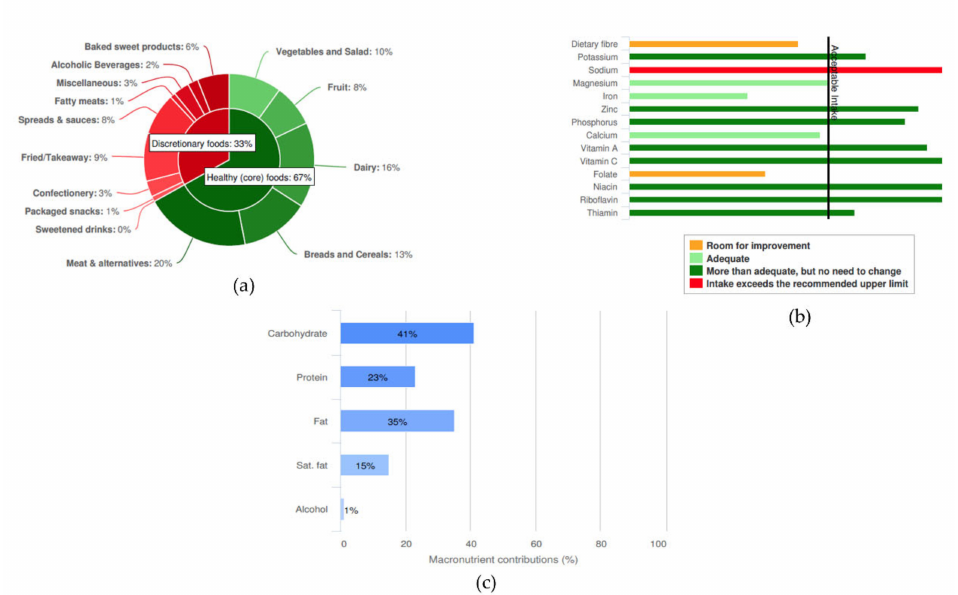
Figure 1. Examples of graphical feedback provided in the Australian Eating Survey ® (AES) report: ( a ) proportion of energy intake from core and non-core food groups; ( b ) adequacy of fibre and micronutrient intake; and ( c ) proportion of energy intake from